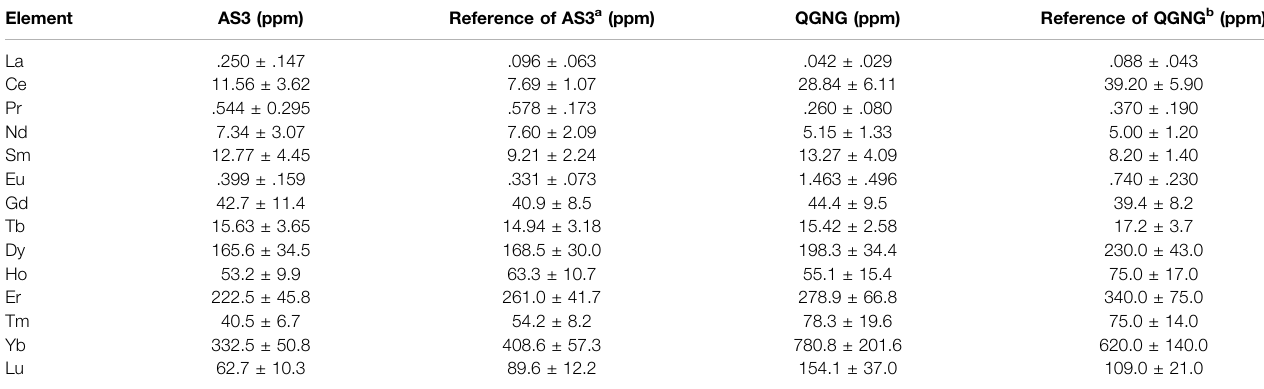
TABLE 3 | Rare earth elements concentrations in AS3 and QGNG zircons together with reference values Element